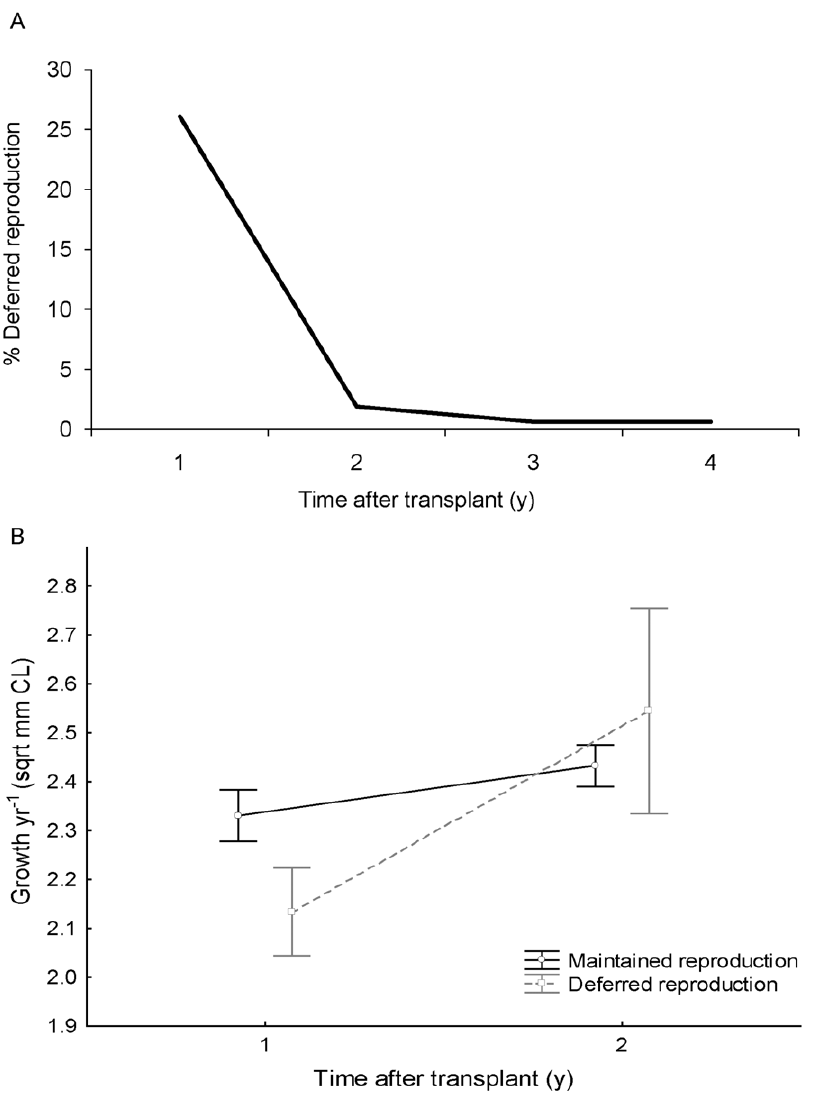
Figure 3. Females with deferred reproduction. a. Percentage of female J. edwardsii that deferred reproduction over 4 years of sampling at Taroona Reserve. b. Growth rate of translocated lobsters that deferred reproduction or maintained reproduction for two years after